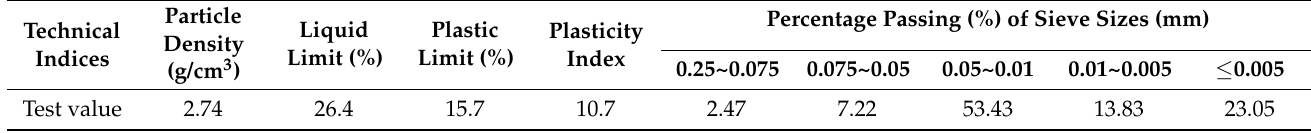
Table 2. Physical properties of